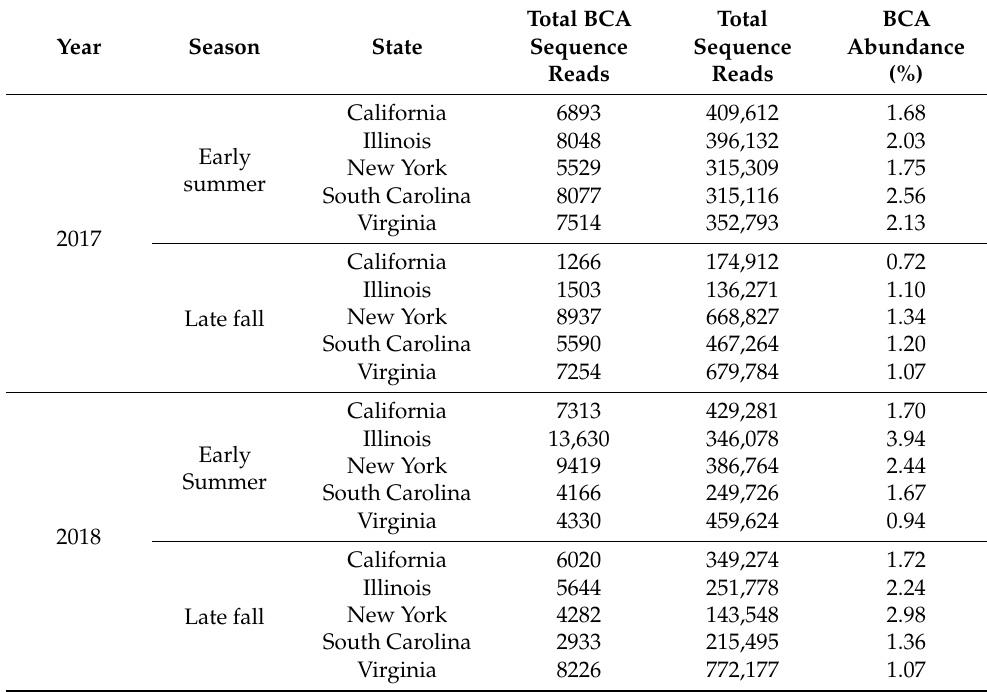
Table 5. Total abundance of 66 bacterial species with potential biological control activities against plant pathogens by year, season, and